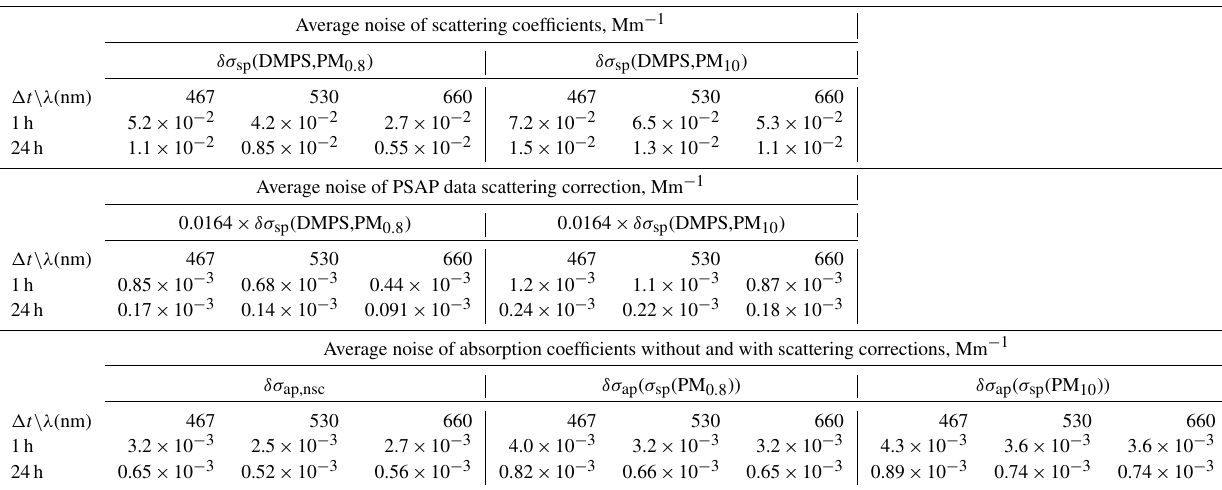
Table 2. Noise of scattering and absorption coefficients calculated from the particle number size distributions and the PSAP data for two averaging times ( (cid:49)t = 1 and 24h). Noise was estimated for the scattering coefficients in the two size ranges ( σ sp (DMPS,PM 0 . 8 ) and σ sp (DMPS,PM 10 )) and for absorption coefficients without scattering corrections ( σ ap,nsc ) and with scattering cor- rections ( σ ap ( σ sp (DMPS,PM 10 . 8 )) and σ ap ( σ sp (DMPS,PM 10 ))) as explained in Sect.